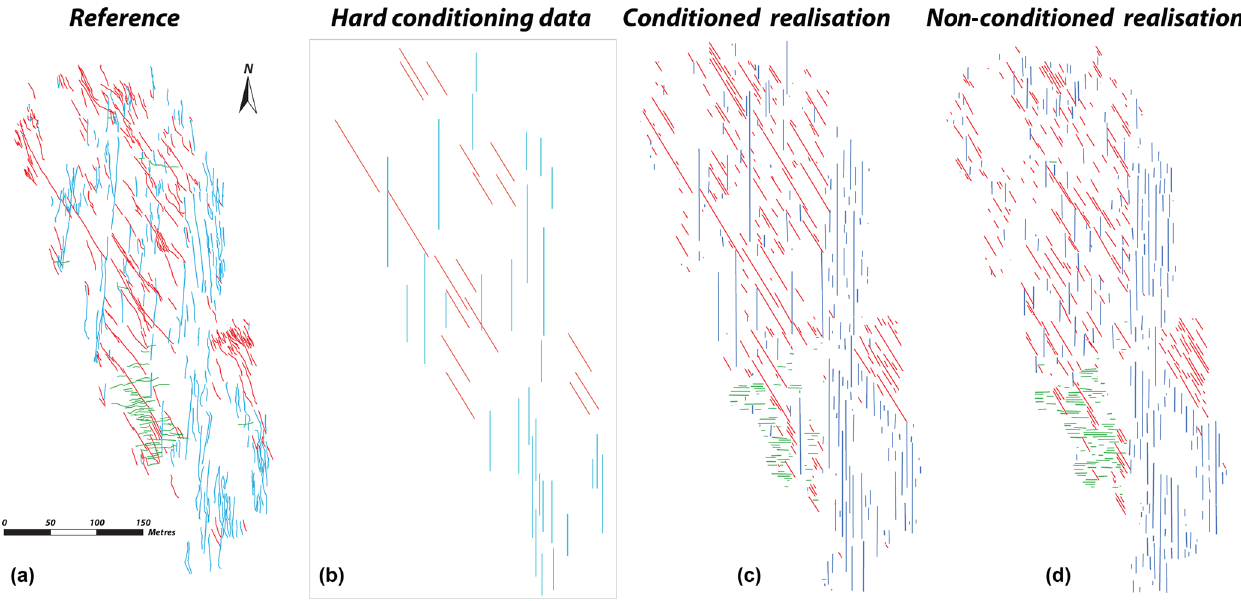
Figure 7. Visual comparison between (a) the reference fracture network interpretation (AP3), (b) the extraction of the longer segments (50 fractures longer than 40m), (c) a simulation conditioned by the long segments and (d) a simulation not conditioned by the long